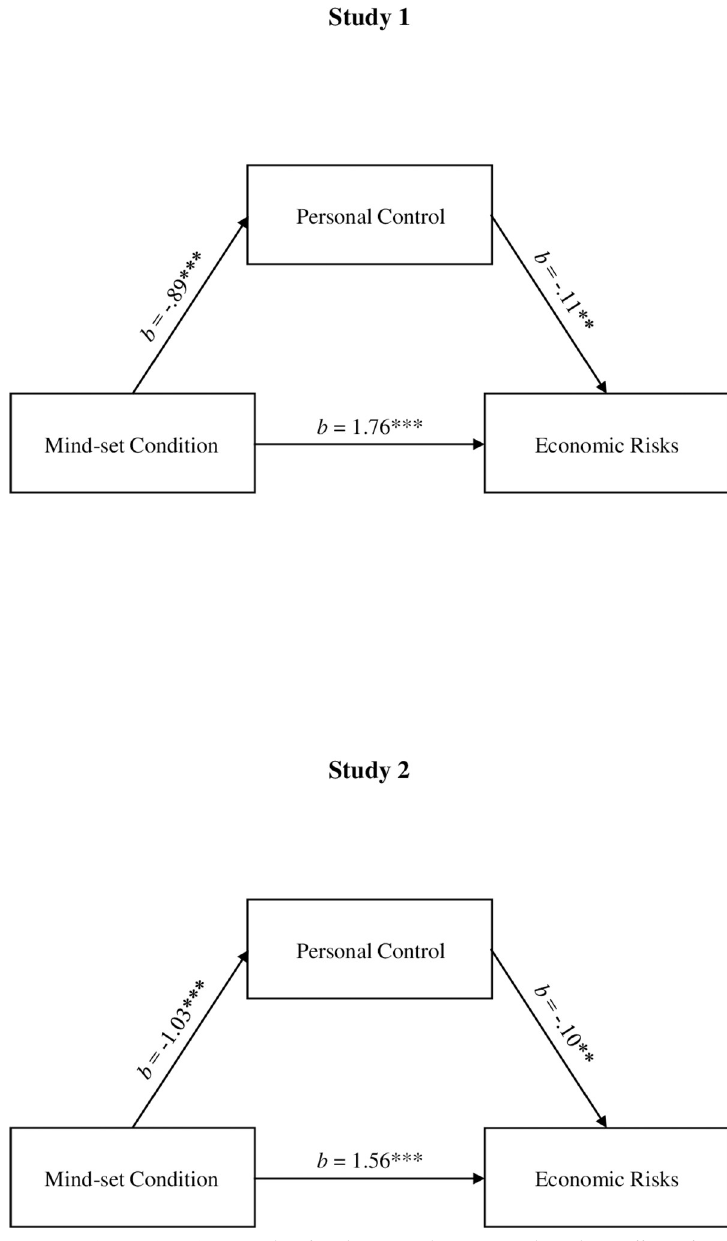
Fig 2. Study 1 and Study 2. Results of mediation analyses testing the indirect effects of mind-set condition (0 = personal, 1 = collective) on economic risks via personal control. Note. Study 1: N = 306. Study 2: N = 384. ��� p < .001, �� p < .01, � p <